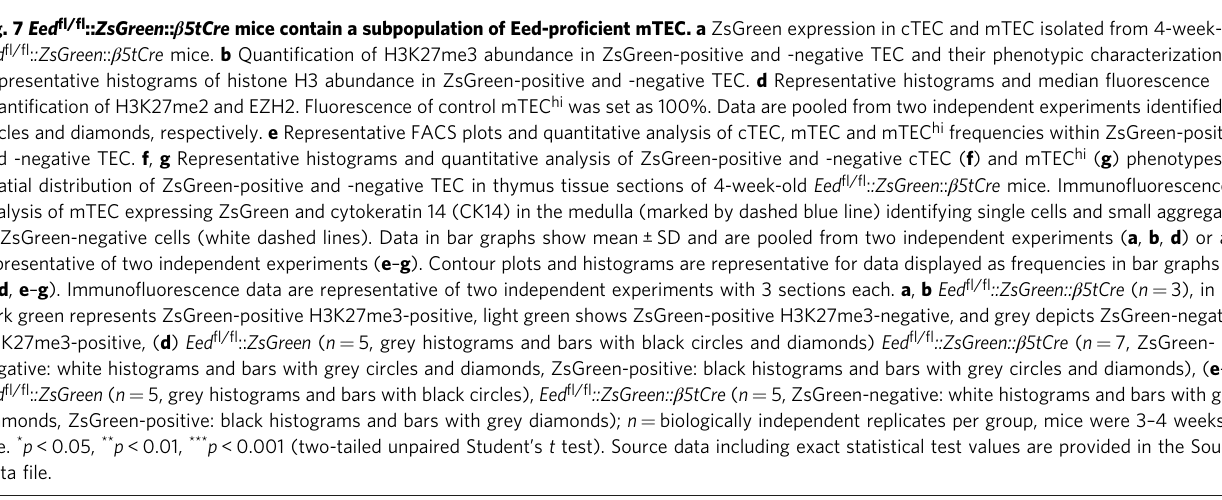
between ZsGreen-negative and Eed fl / fl mTEC (FDR > 0.05).